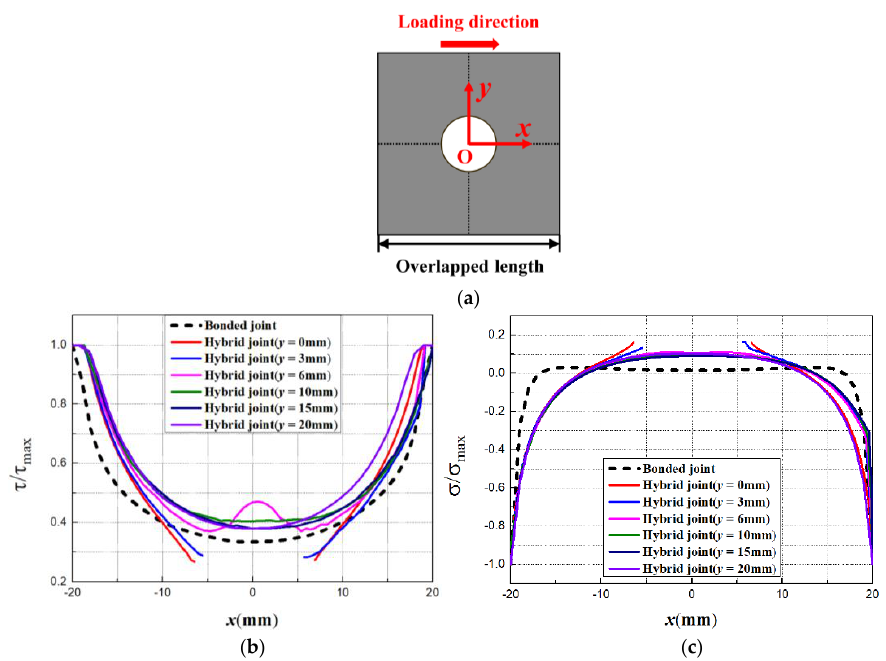
Figure 11. The schematic of overlapped length ( a ); the normalized shear stress ( b ) and peeling stress ( c ) of the adhesive layer in the two kinds of joints.